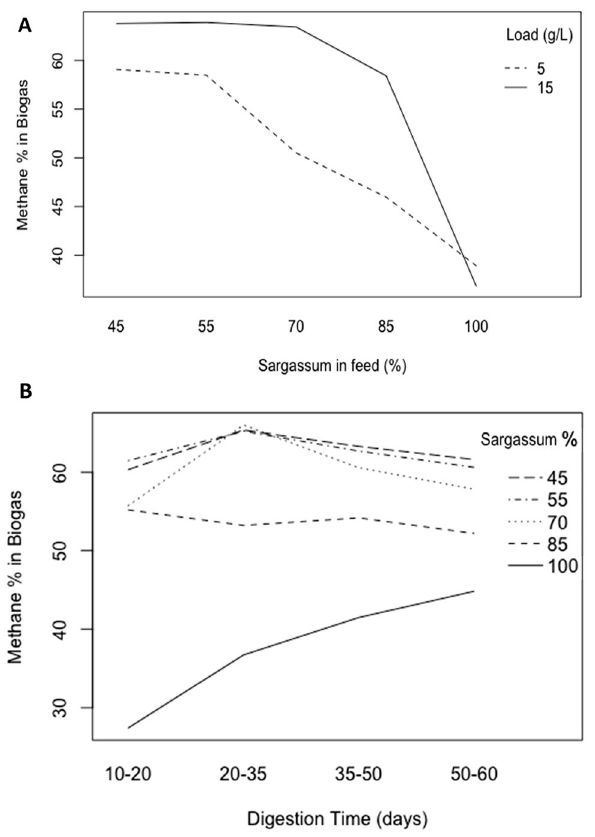
Fig. 2 Interaction plots of the methane percentage in the biogas (%CH 4 ) generated during the co-digestion of Sargassum spp . with food waste at different concentrations in batch system at bench scale. On the top ( A ) is the interaction plot of the organic load and the Sar- gassum spp. % in the feed. On the bottom ( B ), the behavior of %CH throughout the digestion time (60 days) at different Sargassum spp. % in the feed. The plots were extracted from